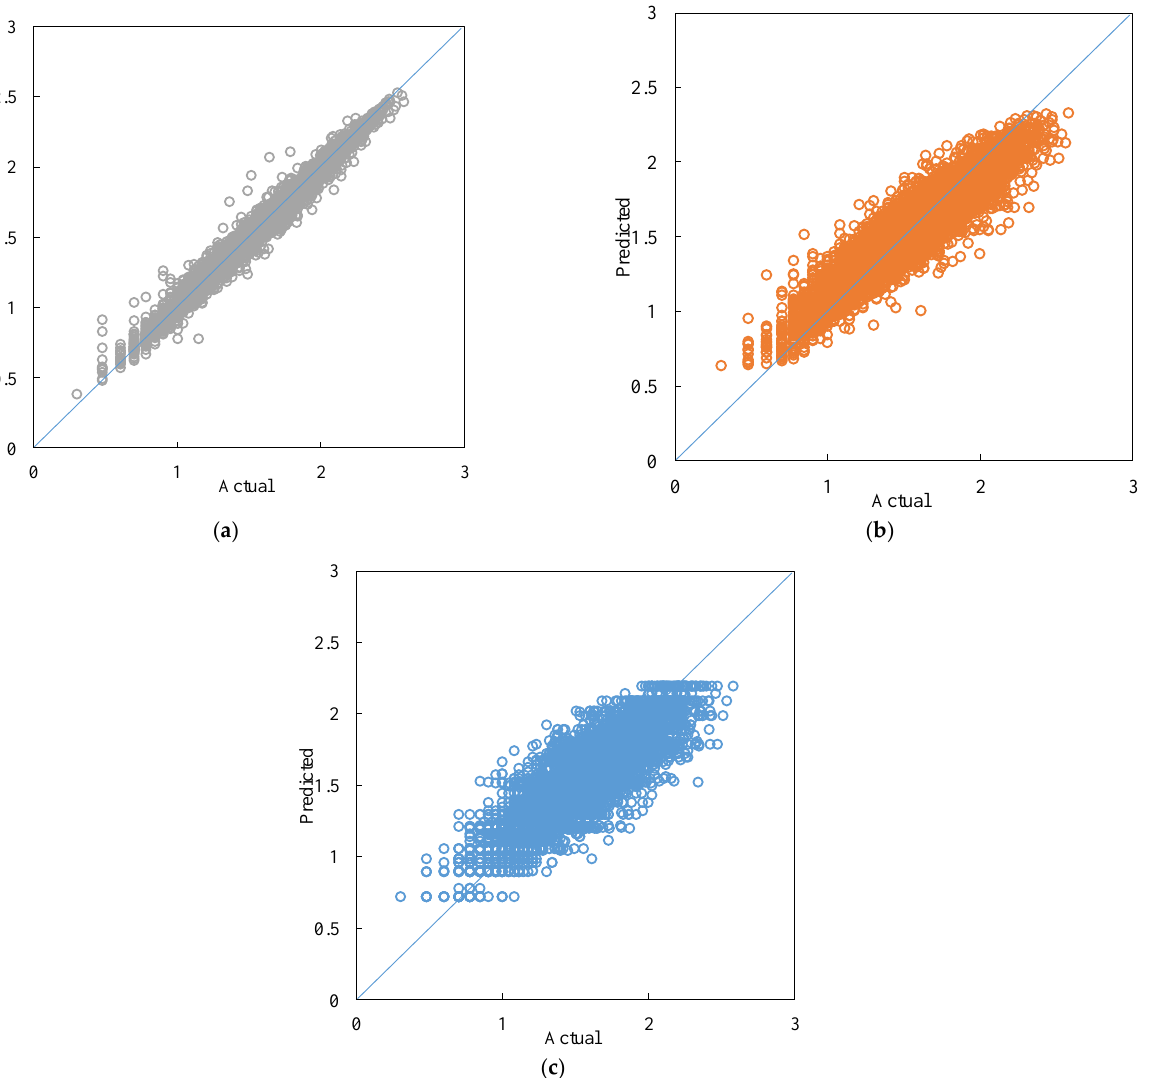
Figure 7. Actual vs. predicted of lg(D 0 – D 20 ) using three machine learning methods: ( a ) GBDT; ( b ) RF; ( c ) CART. Table 3. R-square of three machine learning methods .